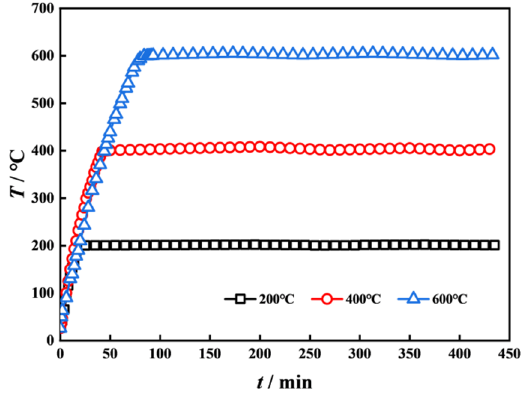
Figure 5. Temperature–time curve of the furnace.